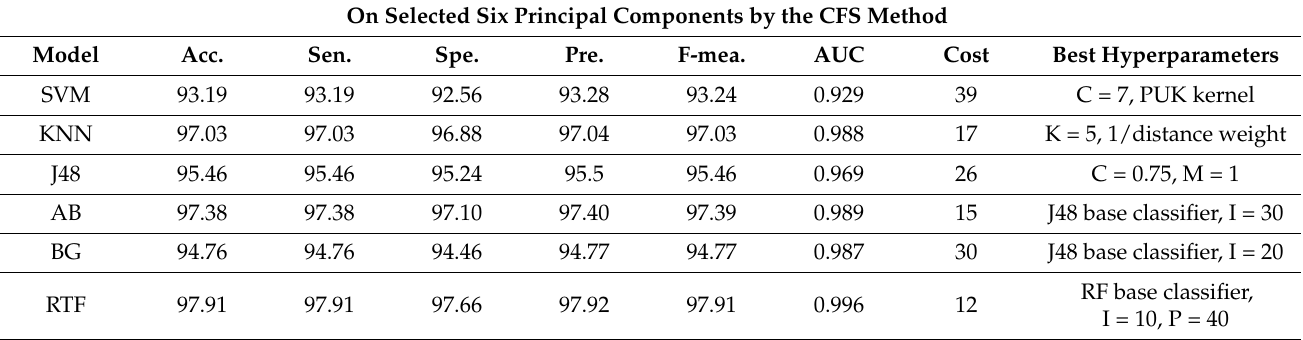
Table 15. Maximum performance measures of the classifiers after hyperparameter optimization. On Selected Six Principal Components by the CFS